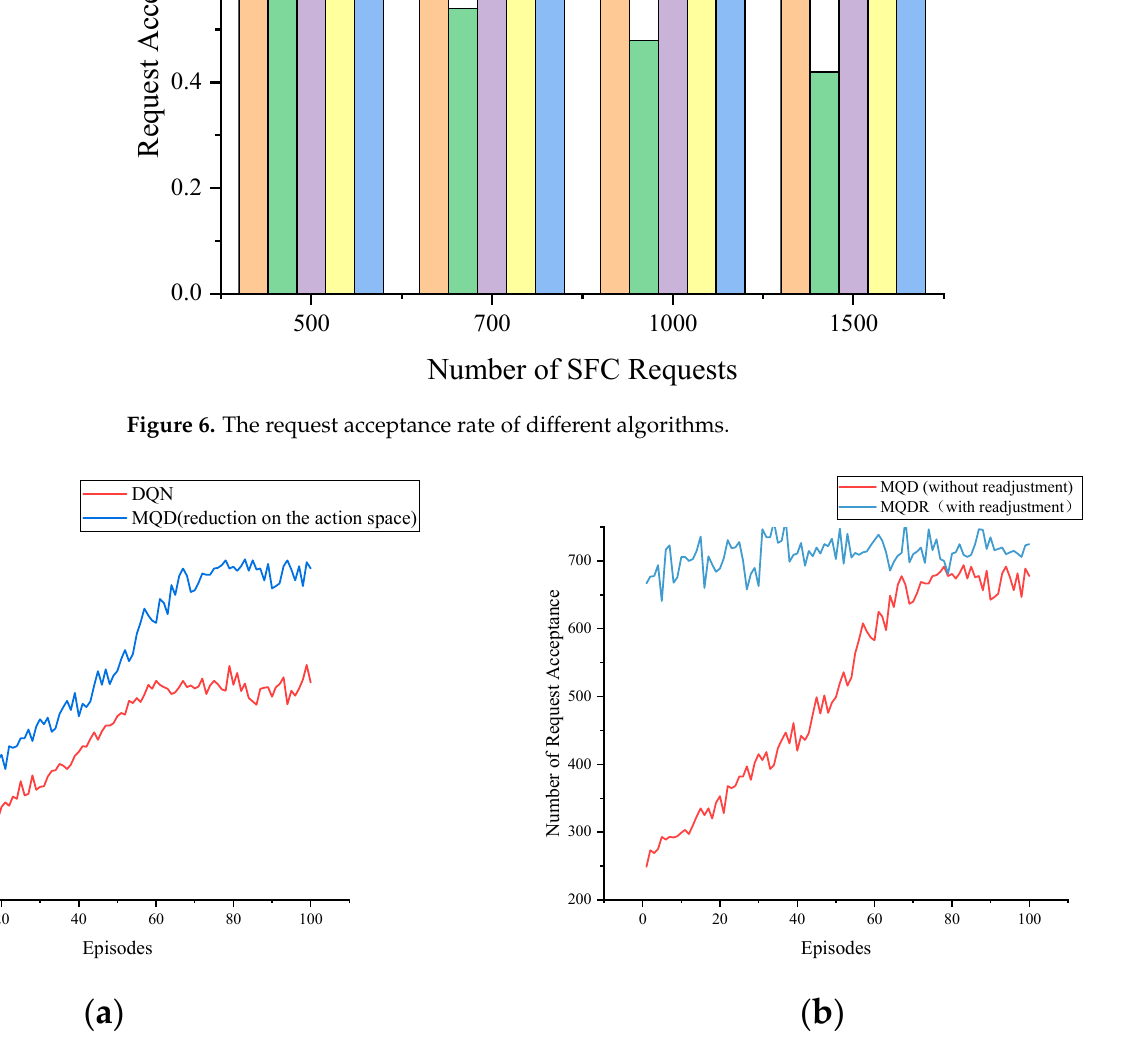
Figure 7. The training process comparison of DQN, MQN, and MQDR. ( a ) Compares the training performance of DQN and MQD, which reduces the action space based on DQN. ( b ) Compares the training performance of the MQD and the MQDR, where the MQDR adds readjustments to the MQD. MQD is the training base for